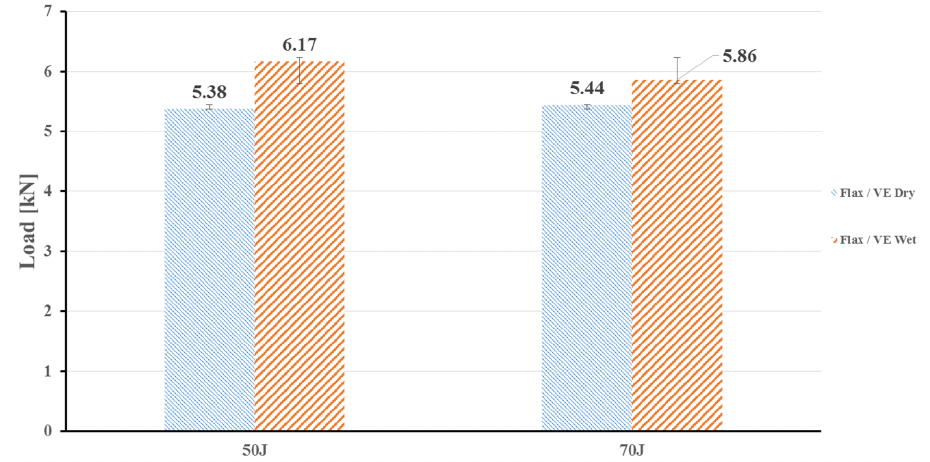
Figure 9. Impact load at different energy levels for flax/VE composites in dry and wet conditions.